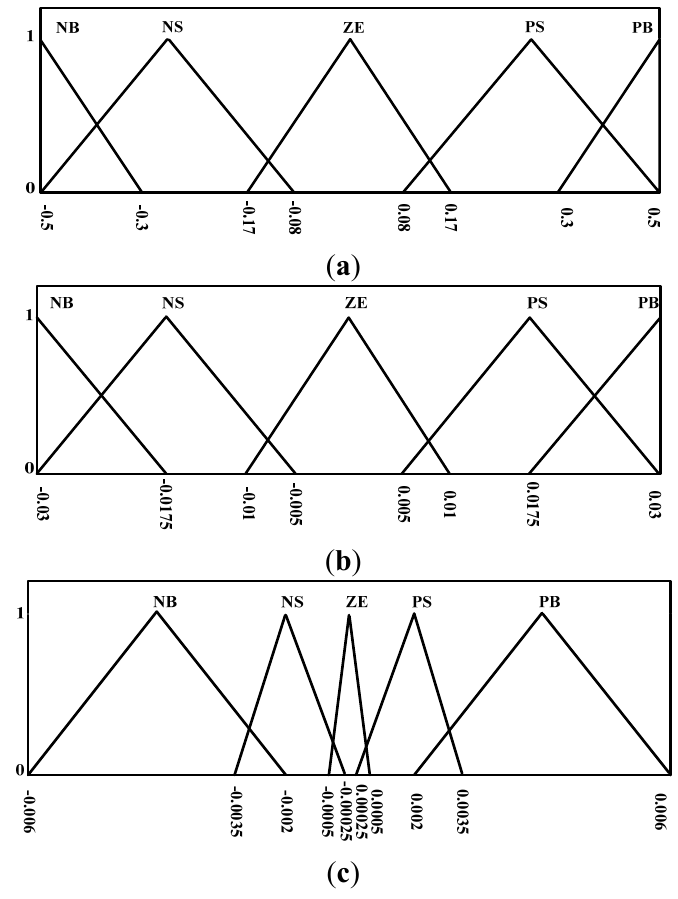
Figure 18. Membership functions for Algorithm (iv): ( a ) Membership function for P-V slope; ( b ) Membership function for changes of slope; ( c ) Membership function for increment of duty ratio